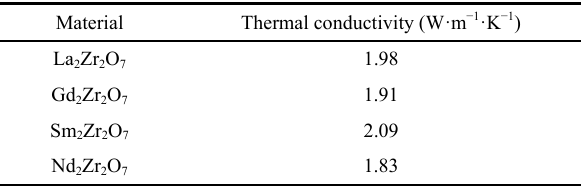
Table 2 Thermal conductivities of some rare-earth zirconate materials at 1473 K